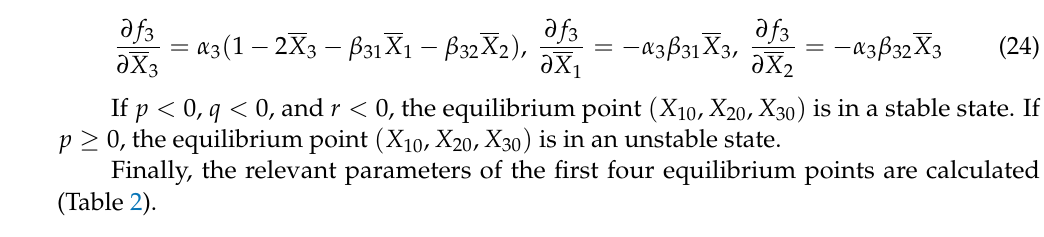
Table 2. The parameters of four equilibrium